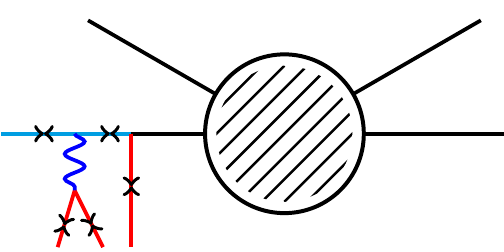
Figure 21 . Feynman diagram for three soft gravitini |